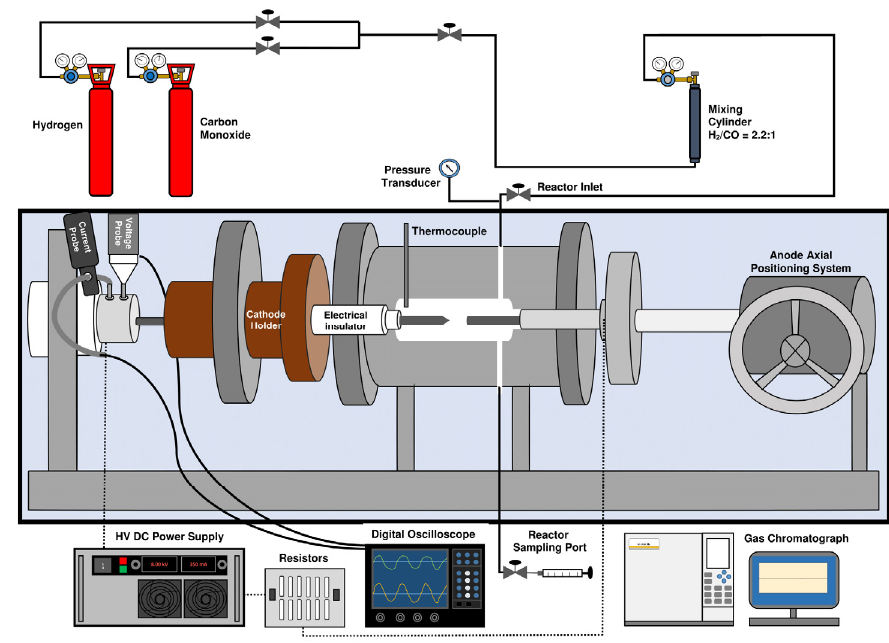
Figure 25. Schematic of the high pressure arc discharge reactor used in this study [9].